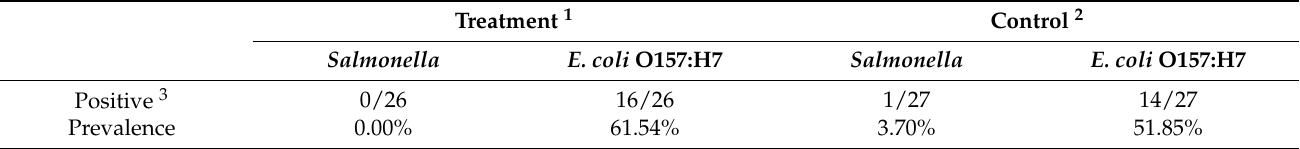
Table 2. Effect of hydrogel on Salmonella and E. coli